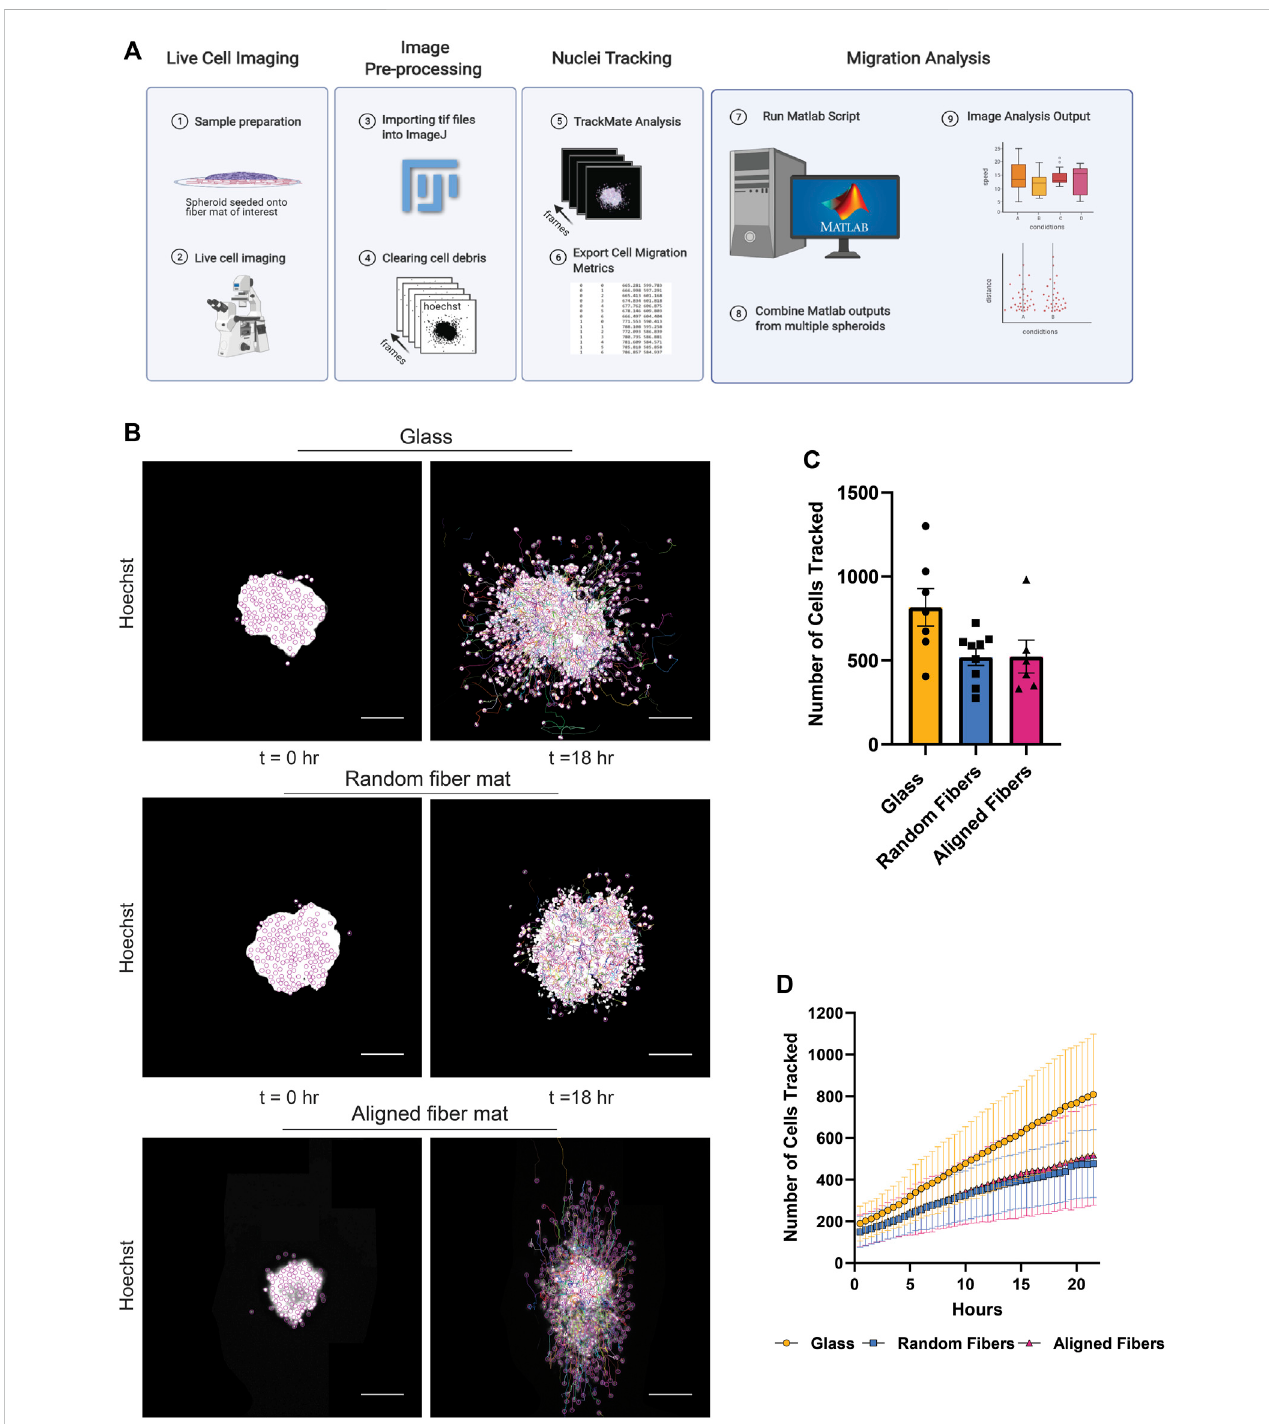
FIGURE 2 Methodology used to obtain cell migration metrics. (A) Work fl ow for image processing to compute cell migration metrics after live cell imaging. (B) Representative fl uorescent images of a MDA-MB-231 spheroid migrating on glass, random or aligned fi ber mats taken at the times 0 and 18 h. (C) Graph depicting thenumberofnuclei trackedat22 hfor spheroidsmigrating onthedifferentsurfaces.Eachpoint representsanindependentexperiment. (D) Graph depicting the number of cells tracked as a function of time. Data represented as a mean ± SEM for C and . ± SD for (D) . Figure 2A created using